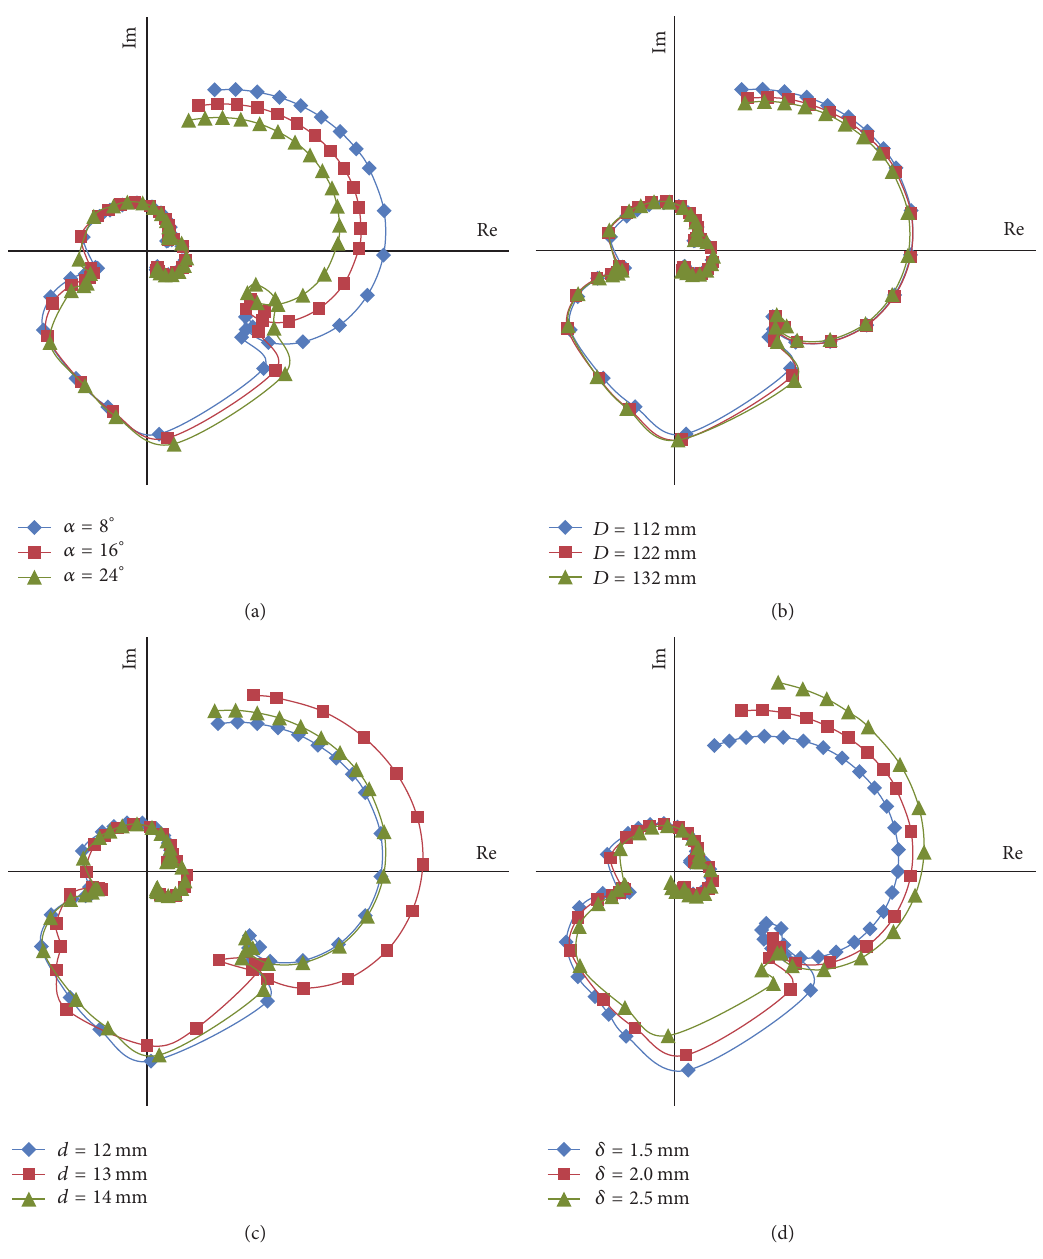
Figure 5: Nyquist curves of the system with a constant heat transfer quantity. (a) Different helix angle. (b) Different helix diameter. (c) Different tube inner diameter. (d) Different wall